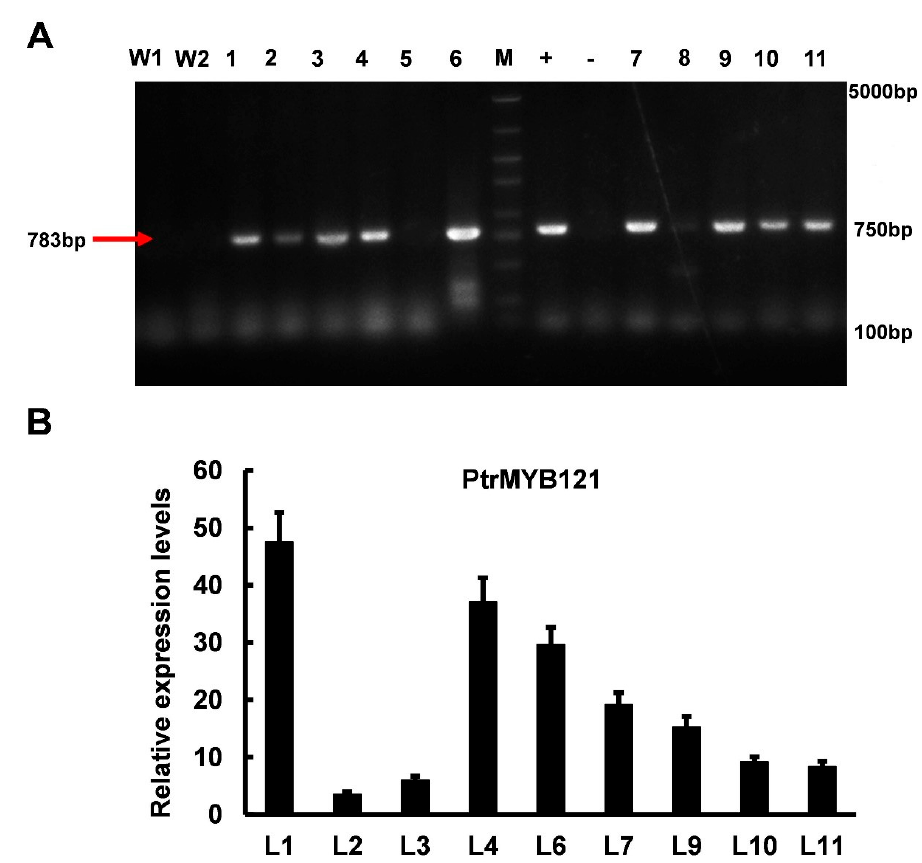
Figure 3. Different transgenic lines of PtrMYB121 -overexpressing Arabidopsis. ( A ) PCR products of different PtrMYB121 -overexpressing lines. W1, wild-type line 1; W2, wild-type line 2; +, positive control (plasmid used for transformation containing hygromycin resistance gene); − , negative control (ddH 2 O); ( B ) Expression profiles of PtrMYB121 in the inflorescence stems of different transgenic lines of T2 generation Arabidopsis.